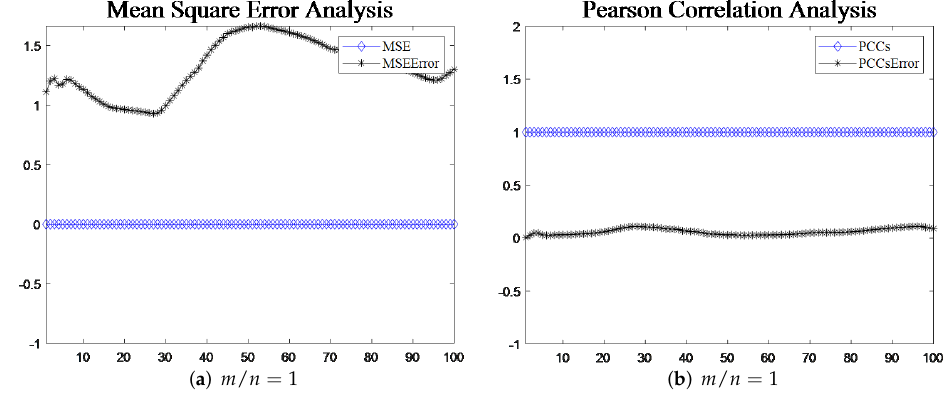
Figure 7. ( a ) MSE comparsion in the uncompressed state. ( b ) PCCs comparsion in the uncom- pressed